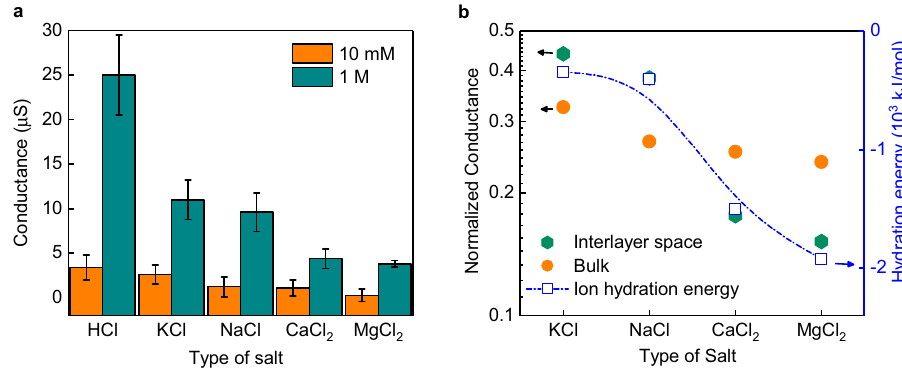
Fig. 4 Steric exclusion and soft type transport through intercalated graphite. a Conductance of several salts for concentrations of 10 mM and 1 M (error bar is calculated from the data of 4 different samples). At lower concentrations, all the salts show very similar conductance, however, at higher concentrations (1 M), the conductance decreases with increase in (de)hydration energy of cations. b Plot of conductance normalized with respect to HCl for various salt solutions, through ICG and an open aperture. The (de)hydration energy of cations, taken from literature 17 is plotted along the right Y-axis as indicated by blue square symbols. Here, (de)hydration energy is the energy required to completely remove the hydration shells of an ion. The blue dotted line is a guide to the eye. There is one to one correspondence between salt conductance and (de)hydration